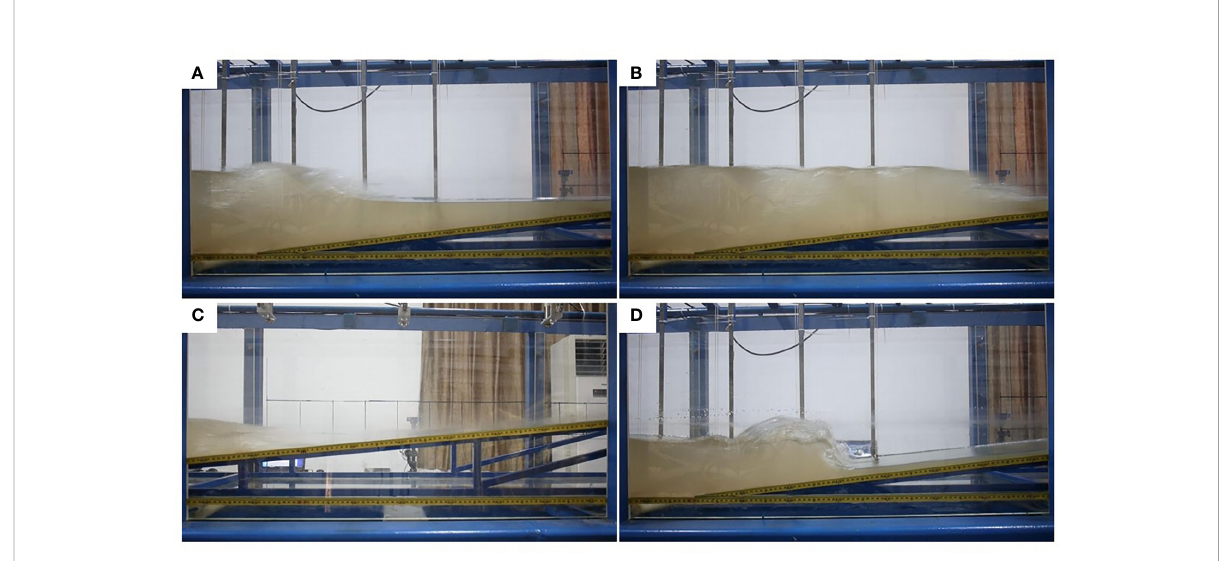
FIGURE 2 Snapshots of the bore evolution on the steep beach: (A) bore forming, t = 1.3 s; (B) bore collapse, t = 2.0 s; (C) uprush, t = 2.3 s; (D) backwash, t = 7.5